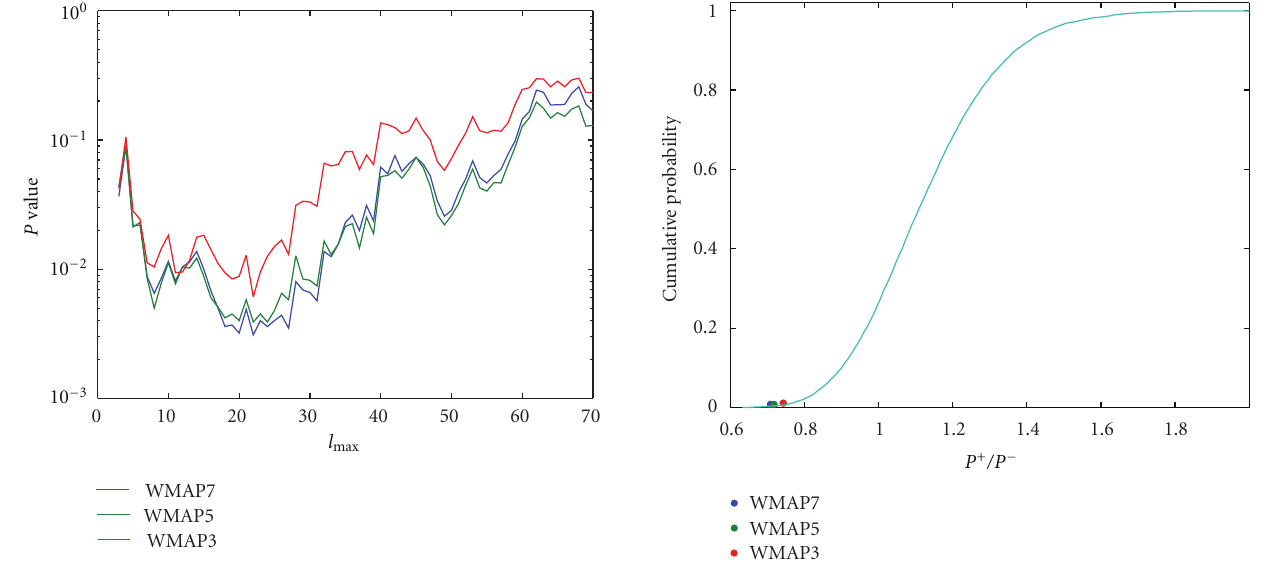
Figure 5: Parity asymmetry at multipoles (2 ≤ l ≤ 22): cumulative distribution of P + /P − for 10 4 simulated maps (cyan), P + /P − of WMAP7 (blue), WMAP5 (green), and WMAP3